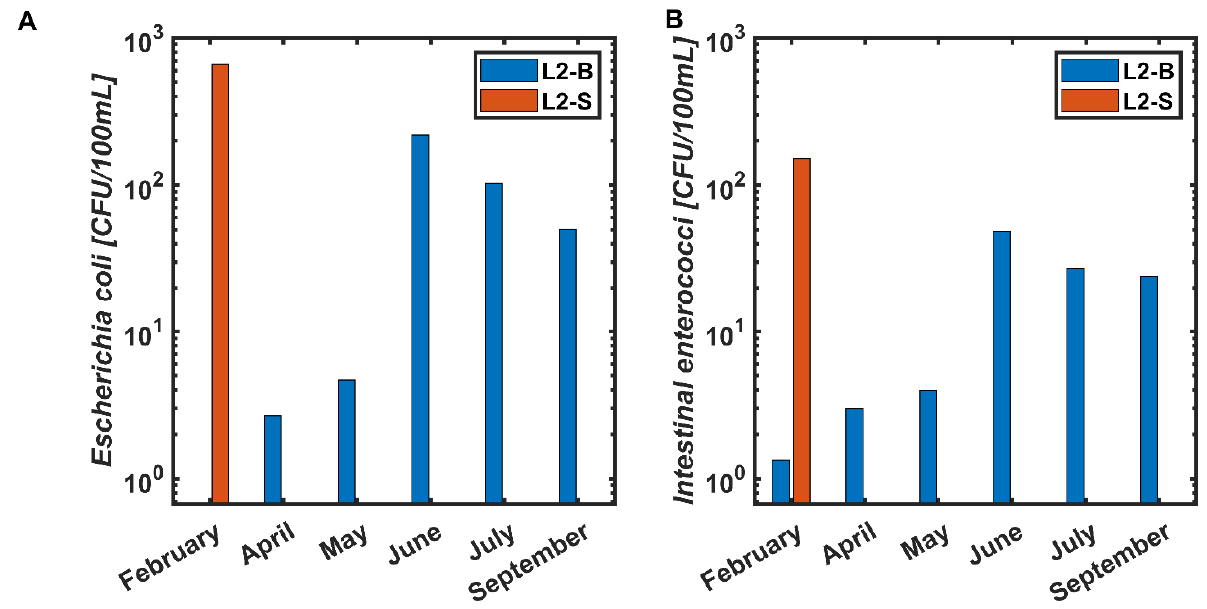
Figure 5. Microbial water quality (( A ) Escherichia coli , ( B ) Intestinal enterococci) at location 2. L2-B refers to location 2 bottom (blue), while L2-S refers to location 2 surface location (orange).